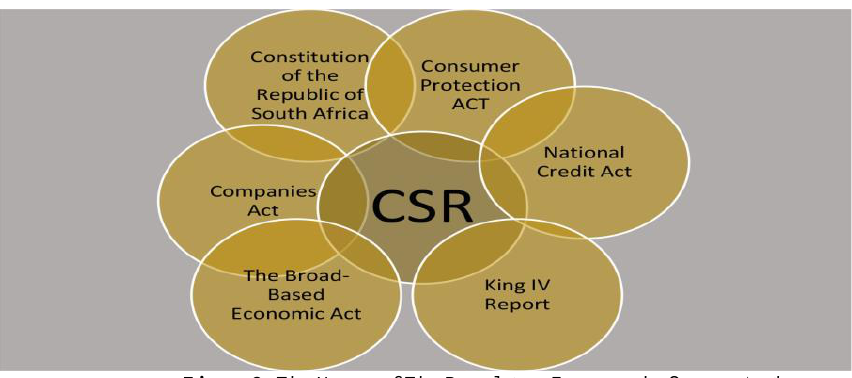
Figure 3: The Nexus of The Regulatory Framework; Source: